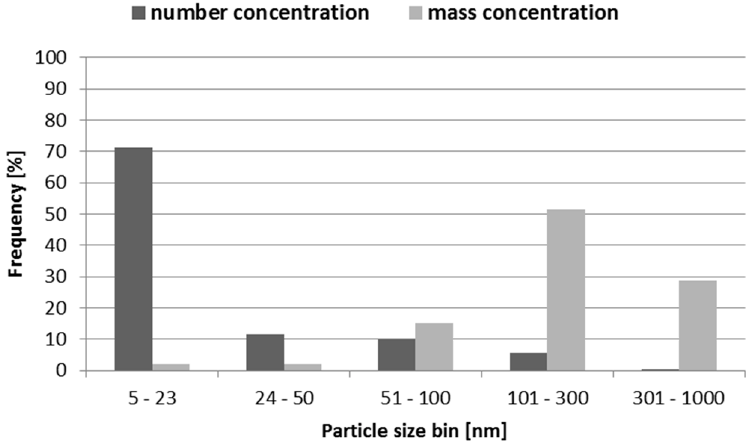
Figure 6. Frequency distribution of number density and mass concentration upon five particle diameter bins.